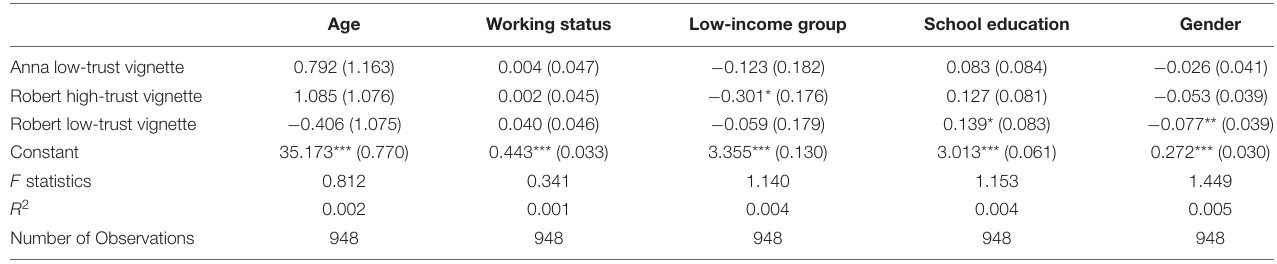
TABLE B1 | Balancing